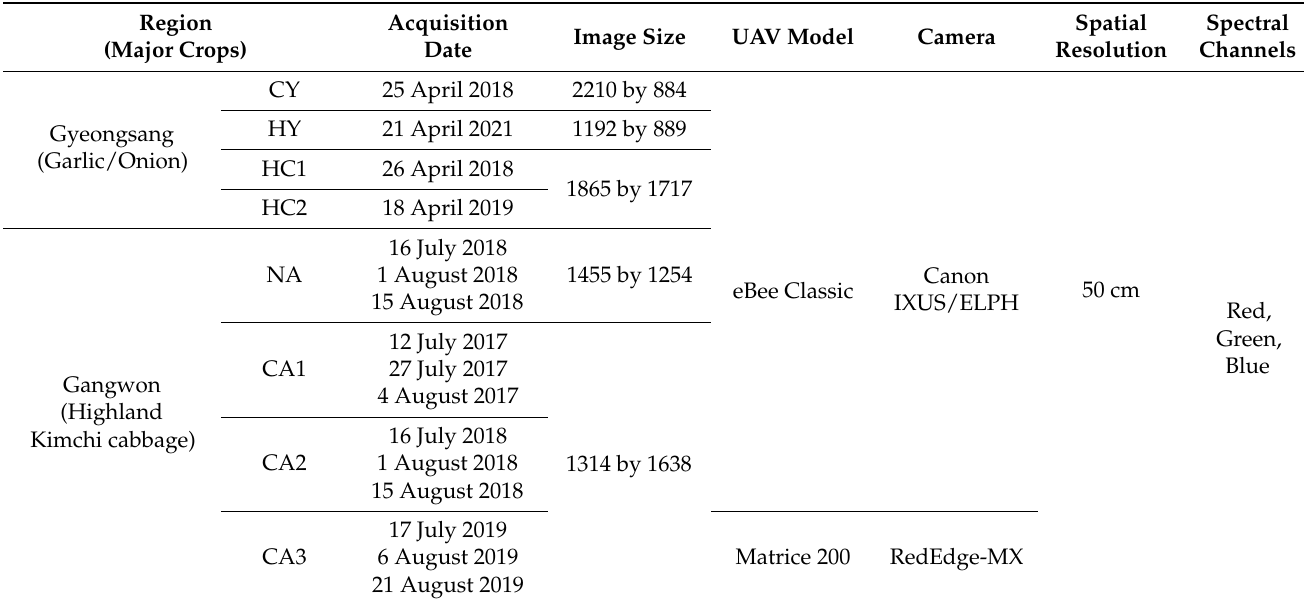
Table 1. A summary of the UAV images used for crop classification in this